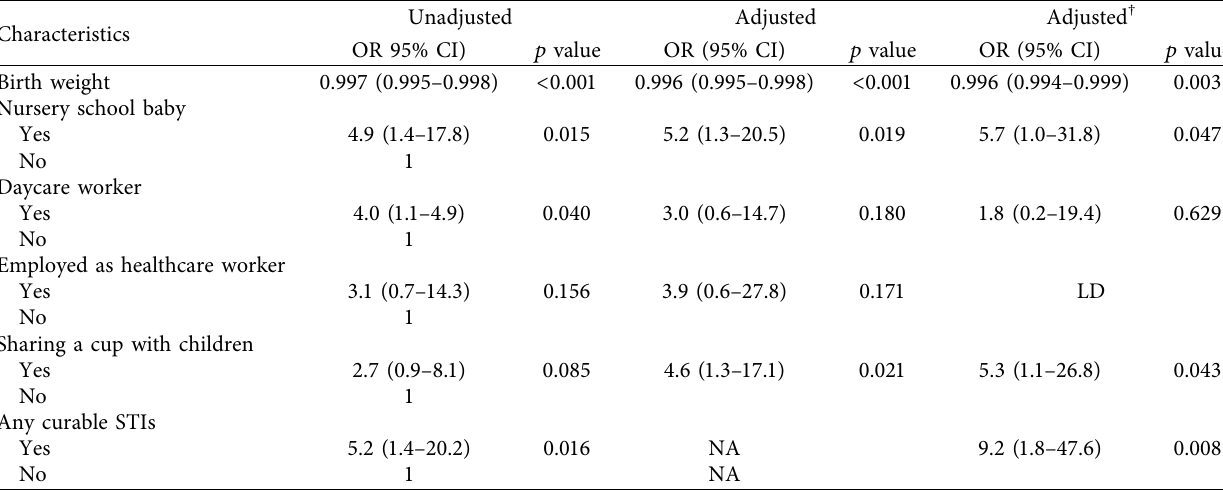
Table 3: Unadjusted and adjusted associated factors with newborn congenital CMV infection.